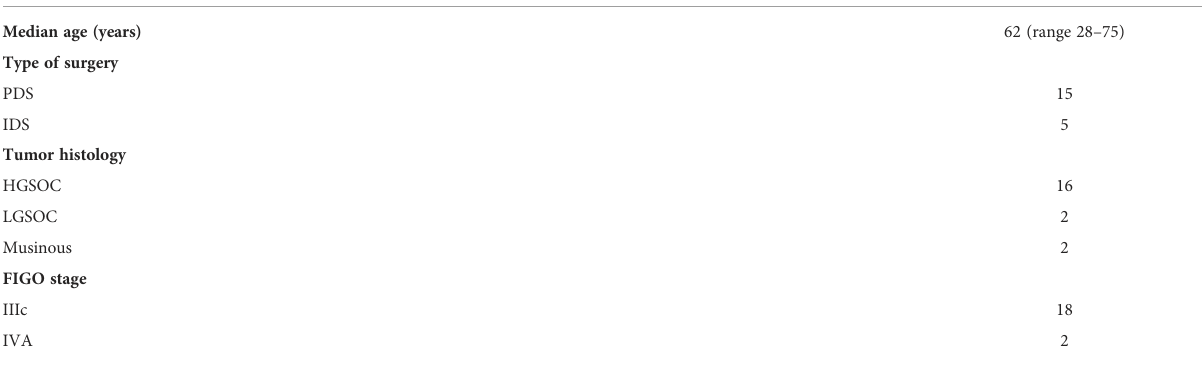
TABLE 2 The clinical characteristics of the included